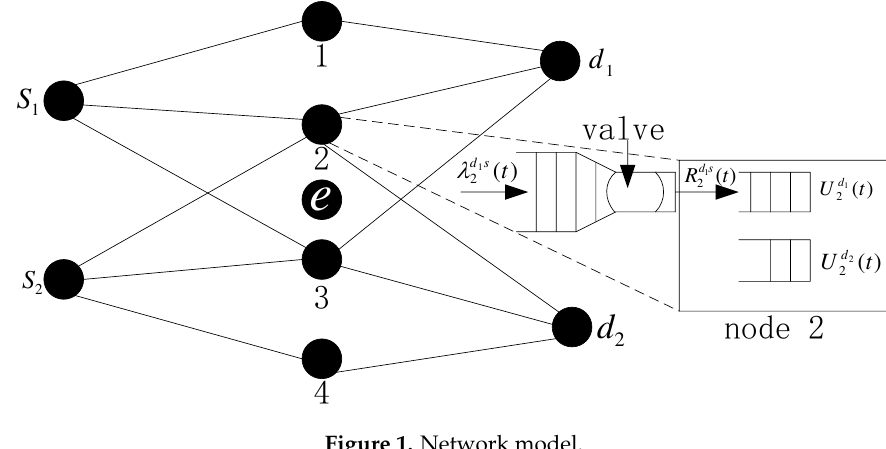
Figure 1. Network